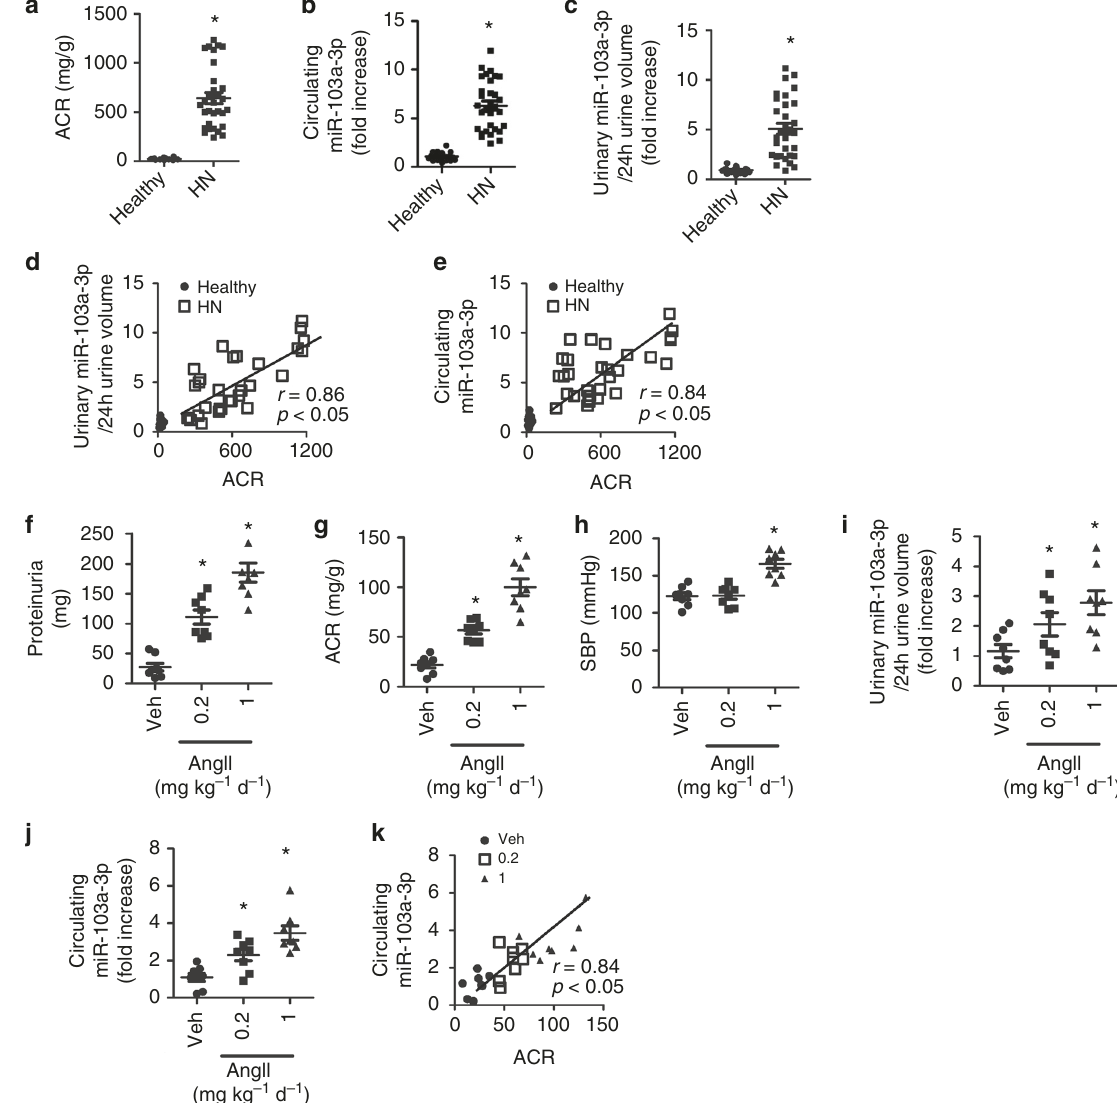
Fig. 1 Circulating miR-103a-3p is upregulated in hypertensive nephropathy patients and AngII-treated mice. a – c Albumin/creatinine ratio (ACR) ( a ), serum miR-103a-3p levels ( b ), and ratio for urinary miR-103a-3p levels to the volume of 24 h urine ( c ) of hypertensive nephropathy (HN) patients ( n = 31) and healthy controls ( n = 18). * p < 0.05 relative to healthy controls (Student ’ s t -test). d , e Correlation between ACR and the ratio for urinary miR-103a-3p levels to the volume of 24 h urine ( d ) or serum miR-103a-3p levels ( e ) in healthy individuals and HN patients. f – k Albumin excretion rates ( f ), ACR ( g ), systolic blood pressure (SBP) ( h ), ratio for urinary miR-103a-3p levels to the volume of 24 h urine ( i ), and serum miR-103a-3p levels ( j ) in wild-type mice ( n = 8) infused with vehicle (Veh) or AngII (0.2 or 1 mg kg − 1 d − 1 ) for 4 weeks. Urinary and serum miR-103a-3p levels were analyzed by qRT-PCR. * p < 0.05, relative to vehicle control. Statistical analysis was carried out with one-way analysis of variance. k Correlation between circulating miR-103a-3p levels and ACR in vehicle- or AngII-infused mice. Data are mean ± SEM. Each symbol represents an individual sample. The corresponding source data are available in the Source Data fi patients and AngII-infused mice, we performed computational IV (Fig. 3h, i). Similar reductions in miR-103a-3p levels (Sup- target-scan analysis 30 . The analysis identi fi ed two highly con- served miR-103a-3p binding sites within the SNRK mRNA 3 ′ untranslated region (3 ′ UTR) at positions 167 – 173 and 1994 – 2000 (Supplementary Fig. 5c and d) were observed following knock- (Fig. 4a). To assess whether miR-103a-3p regulates SNRK down of miR-103a-3p using AAV-anti-miR-103a-3p. Taken expression, we examined Snrk protein and mRNA levels in glo- together, these fi ndings suggest that loss or inhibition of miR- merular endothelial cells (GnECs) transfected with miR-103a-3p 103a-3p can reduce AngII-induced renal in fl ammation and or anti-miR-103a-3p. Overexpression of miR-103a-3p sig- injury. ni fi cantly reduced Snrk expression (Fig. 4b, c), whereas anti-miR- 103a-3p increased mRNA and protein levels of Snrk (Fig. 4d, e). ′ Next, we used a luciferase reporter assay to test whether the SNRK is a target of miR-103a-3p . To predict the effective target regulatory effect of miR-103a-3p requires the predicted binding sites of miR-103a-3p, which was upregulated in both hypertensive